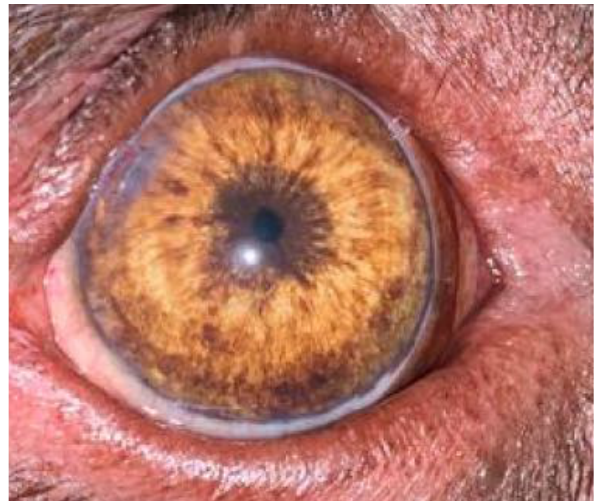
Figure 14. The effect of latanoprost application, leading to extreme pupil (North Downs Specialist